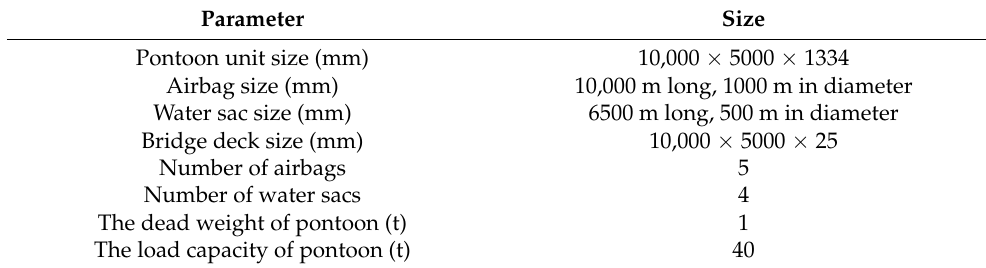
Table 2. Design parameters of the floating